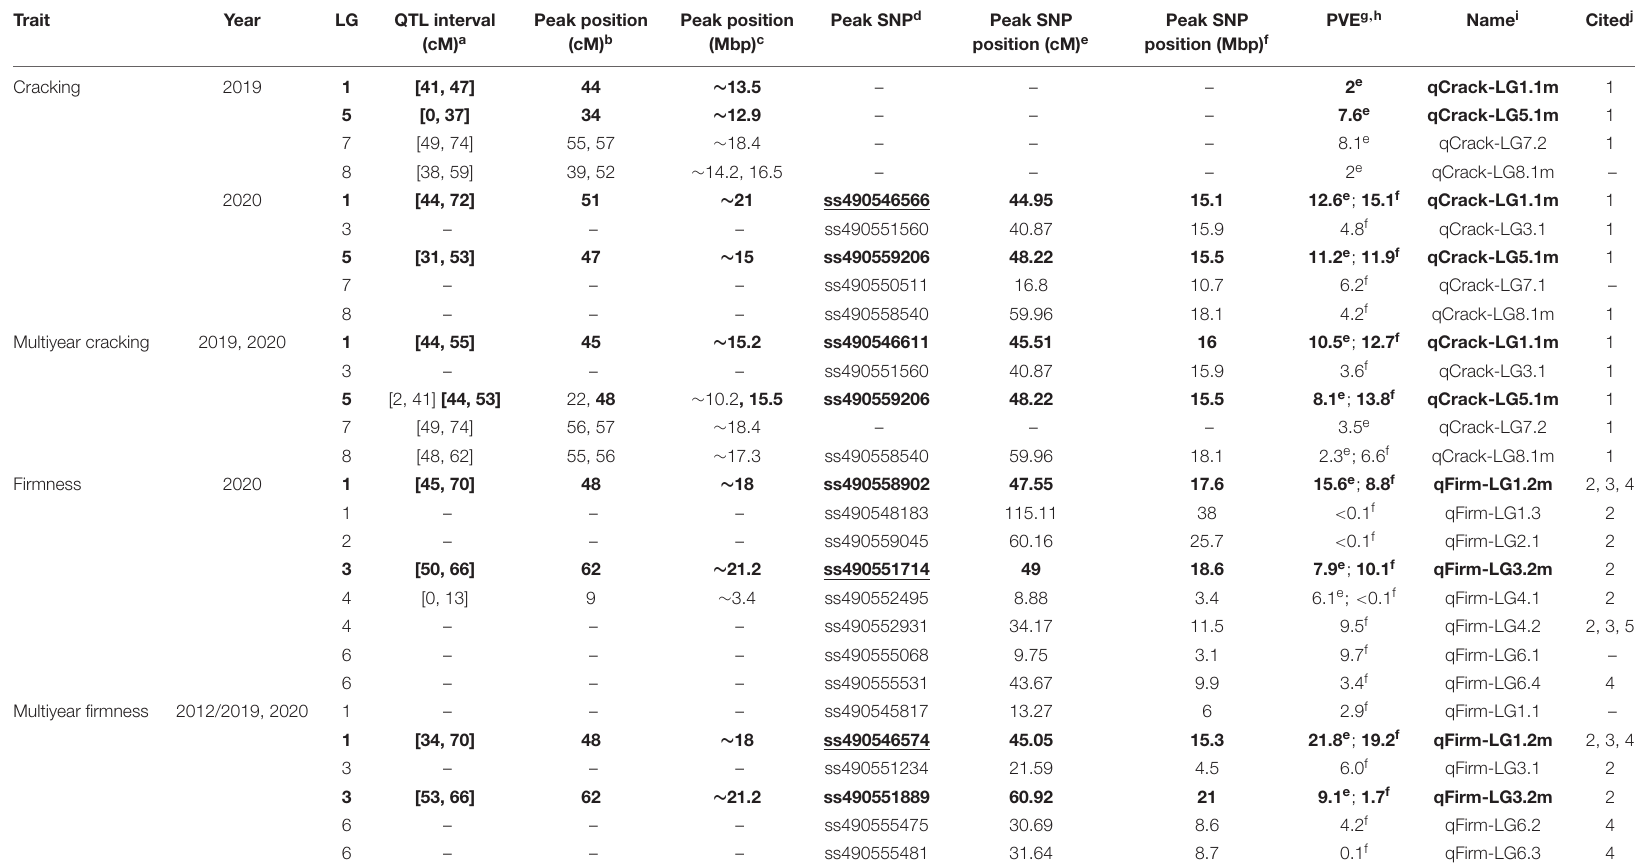
TABLE 1 | All quantitative trait loci (QTLs) detected from the Combined seedling population using the final reduced map FlexQTL TM analysis or BLINK. Trait